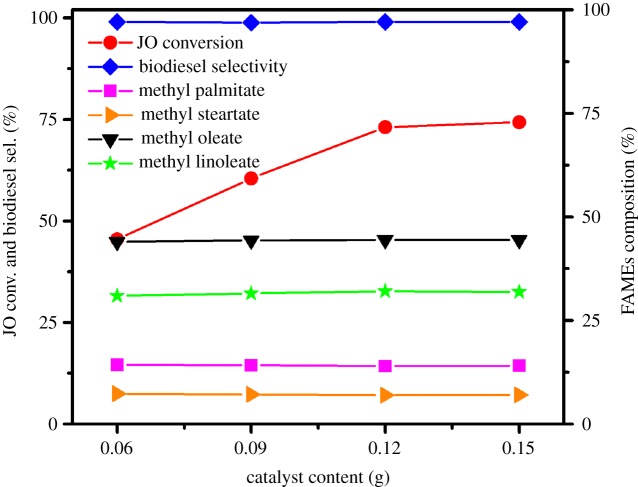
Effect of the catalyst content on transesterification of JO. Reaction conditions: JO 3.0 g, methanol 1.0 g, petroleum ether 1.0 g, 1.5SO42−/TiO2 catalyst, 393 K, 24 h, stirring rate 600 r.p.m.